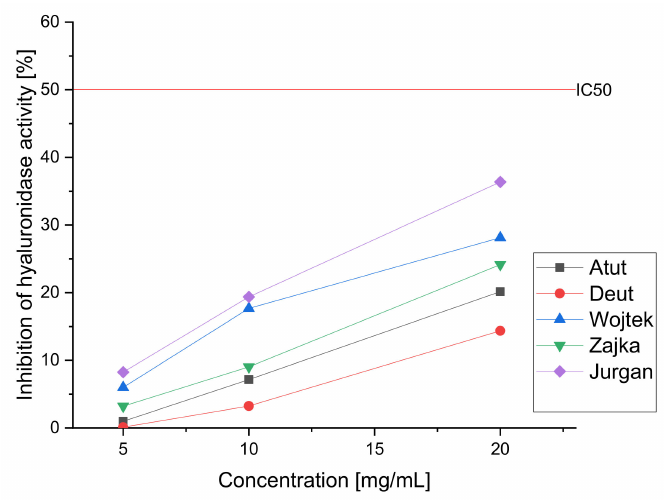
Figure 3. Inhibition of hyaluronidase activity by aqueous extracts of haskap berry leaves.